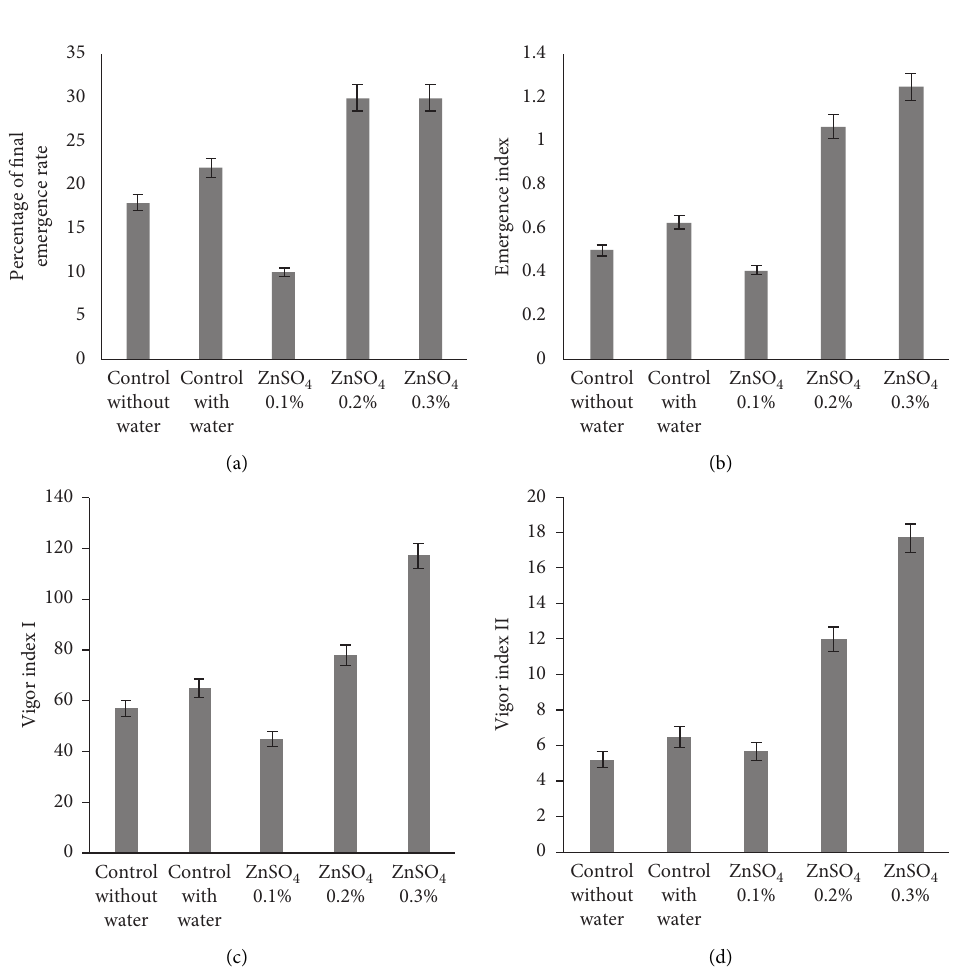
Figure 1: Optimization of zinc sulfate level as priming agent for M. charantia in terms of seedling